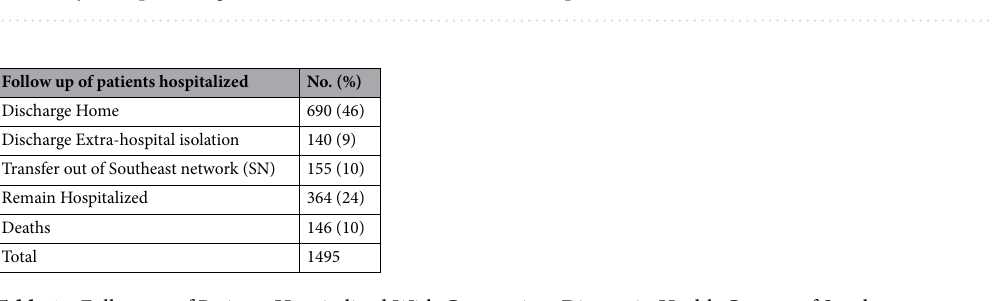
Figure 1. Availability of beds in Southeast Network since March 2020 to August 2020. Availability of beds by area, in Intensive Therapy Unit (ITU) stay, or General Ward with oxygen therapy (GWo), or General Ward (GW) stay. And percentage of increase in beds from March to September.